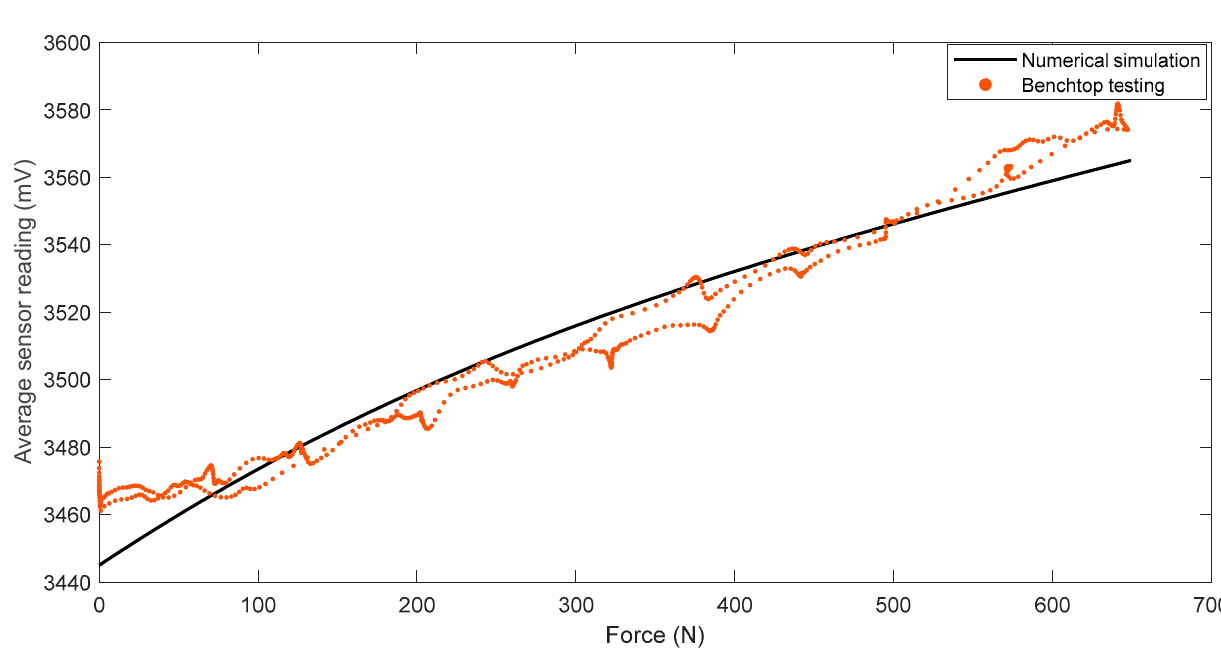
Figure 14. Comparison of sensor readings from numerical simulation and benchtop testing of the